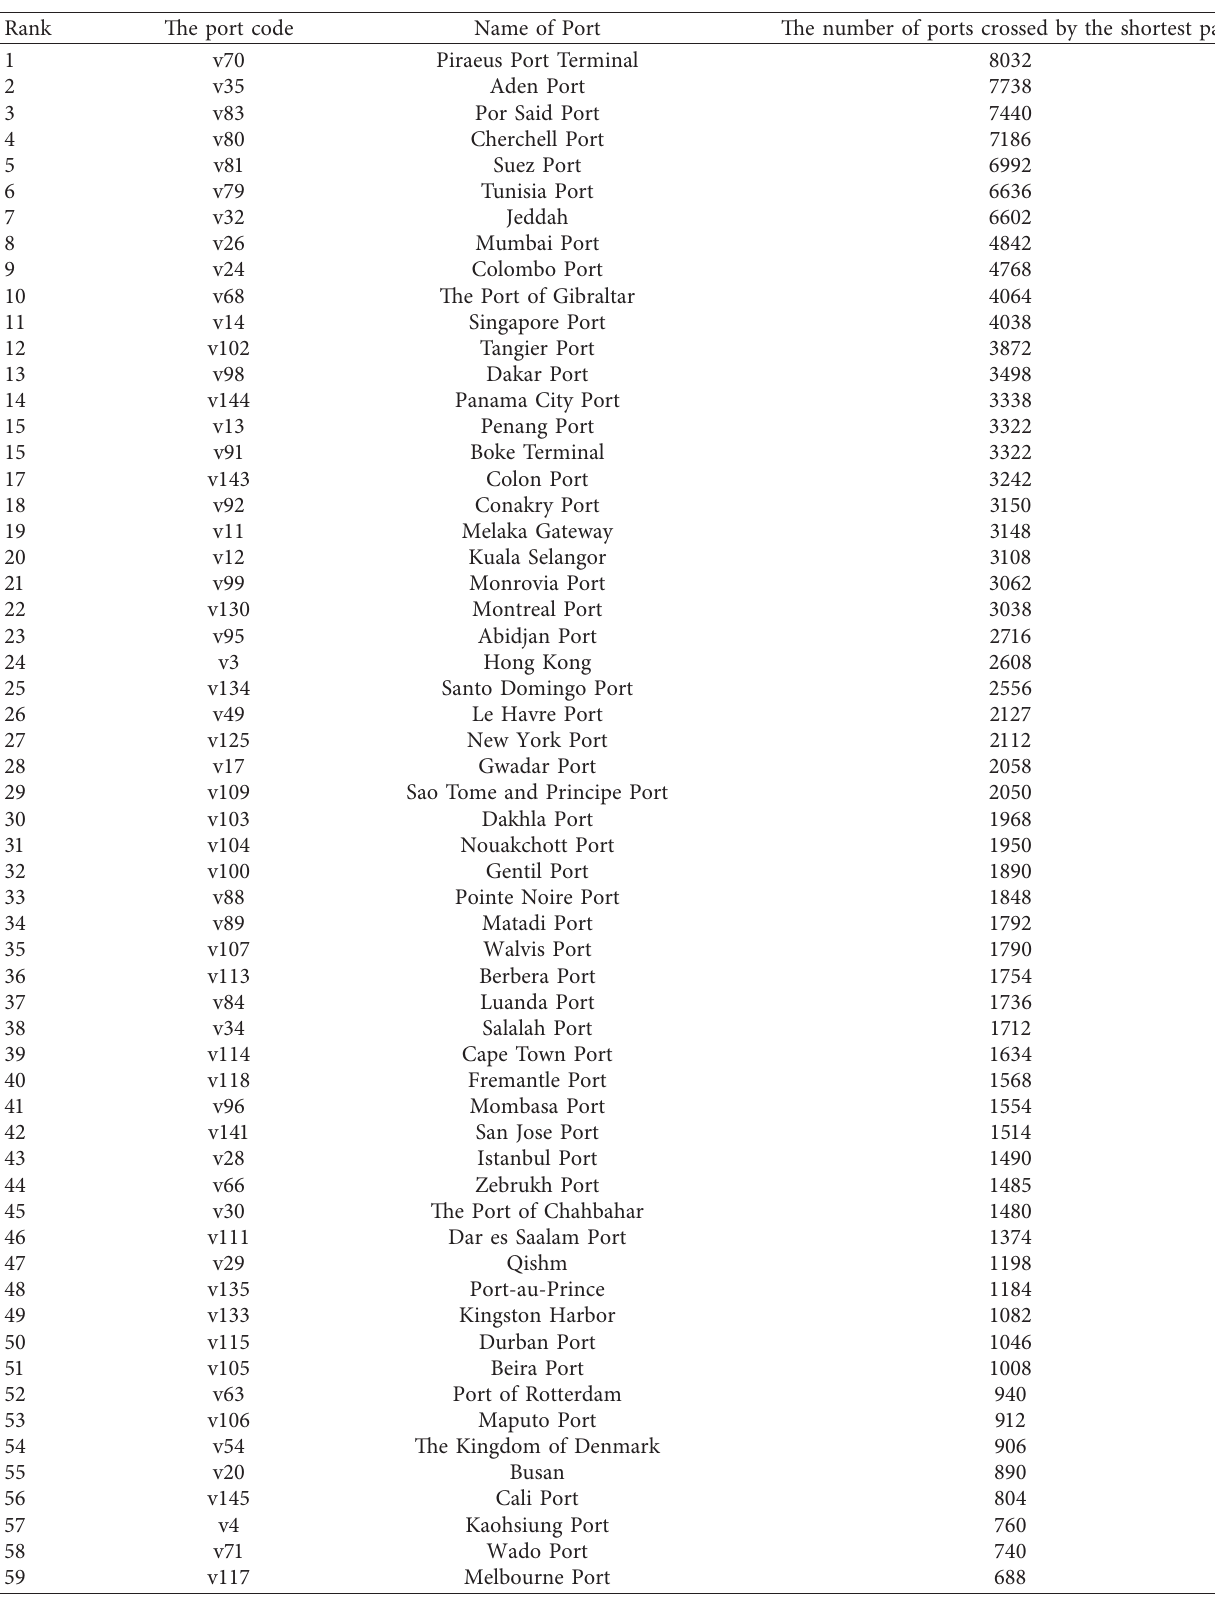
Table 2: The number of ports crossed by the shortest path (ports with values equal to 0 are not listed in the table; they can be searched or downloaded from the following link: